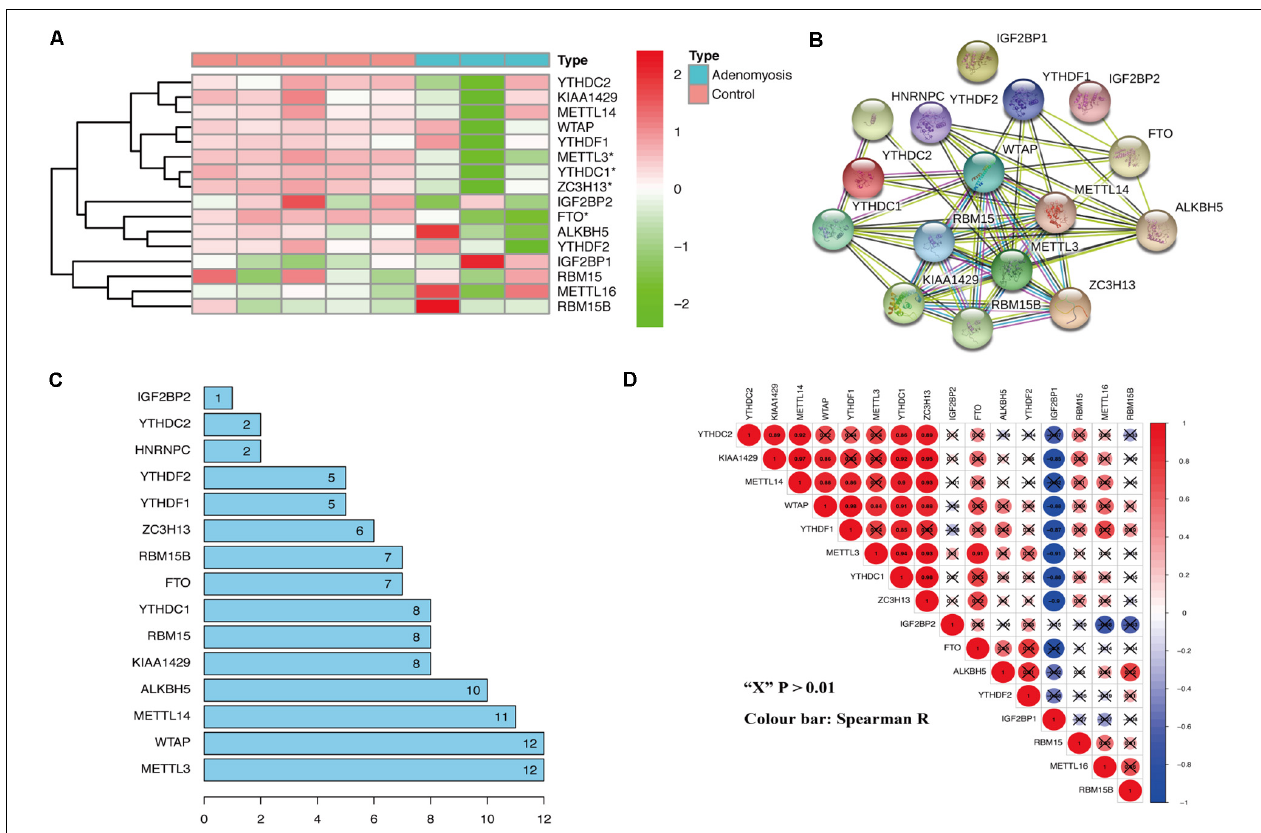
FIGURE 1 | The expression and interaction of m 6 A RNA methylation regulators in the eutopic endometrium of women with and without adenomyosis. (A) The expression levels of sixteen m 6 A RNA methylation regulators in the eutopic endometrium. (B) The m 6 A modification-related interactions among the 16 m 6 A RNA methylation regulators. (C) The interaction counts of 16 m 6 A RNA methylation regulators. (D) Spearman correlation analysis of the 16 m 6 A modification